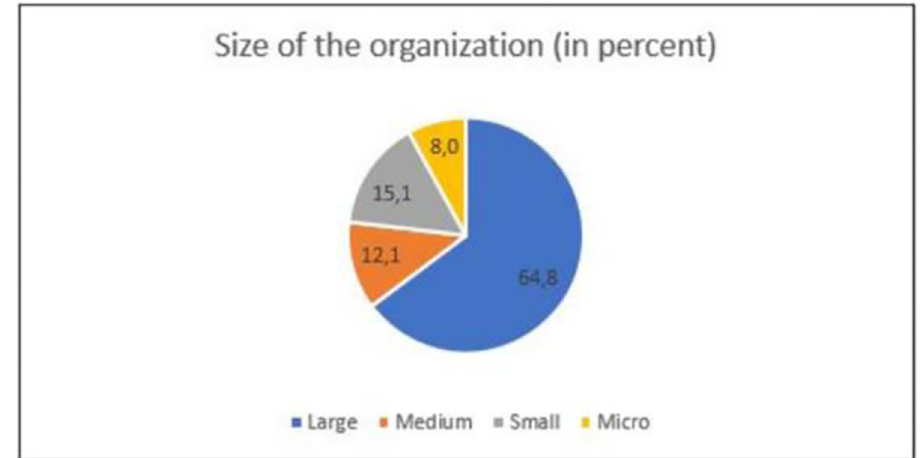
Fig 3. Size of the respondent´s organization. Source: By the